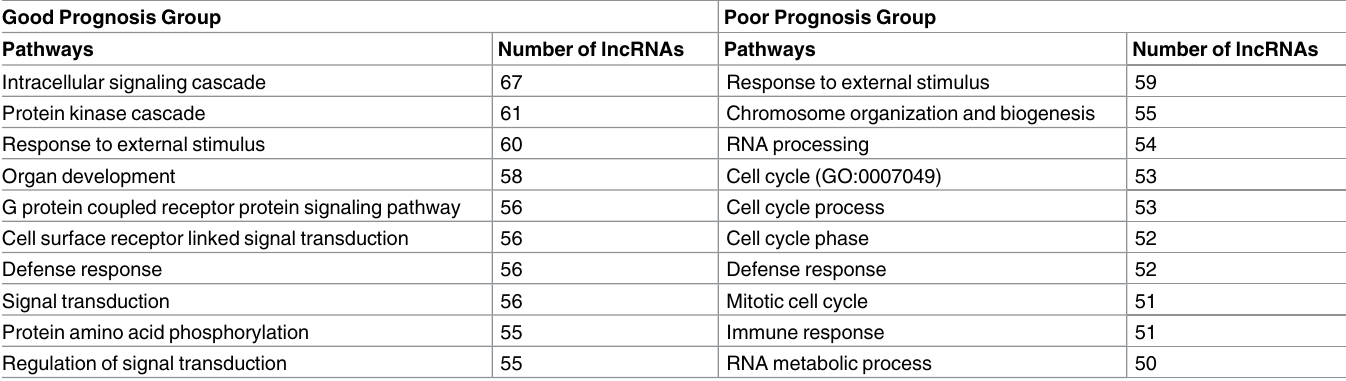
Table 1. Enriched biological pathways associated with prognostic lncRNAs by guilt-by-association analysis. Good Prognosis